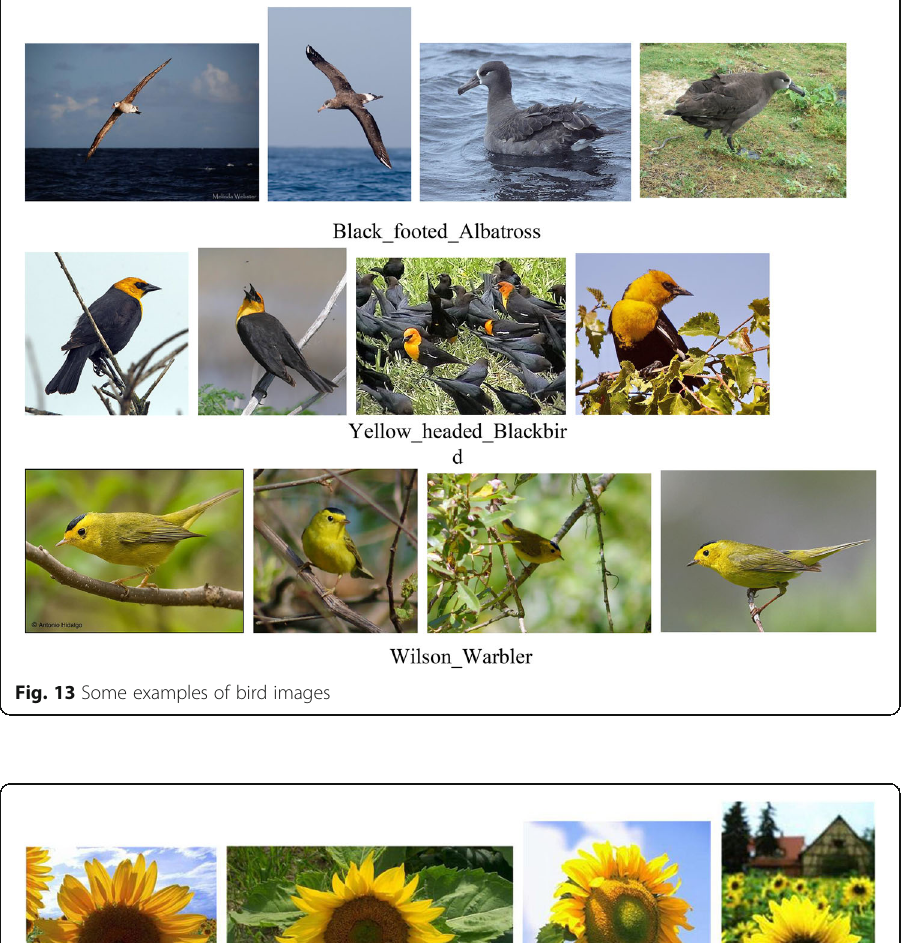
Fig. 13 Some examples of bird images